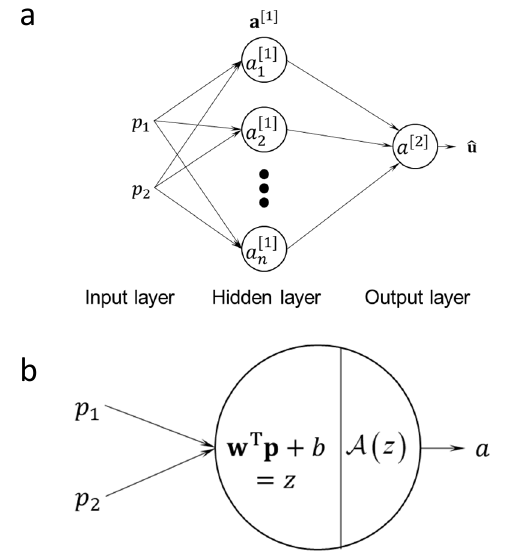
Figure 2. a) A basic ANN structure with one hidden layer and (b) detailed computational process within one neuron. Physics ‐ informed neural